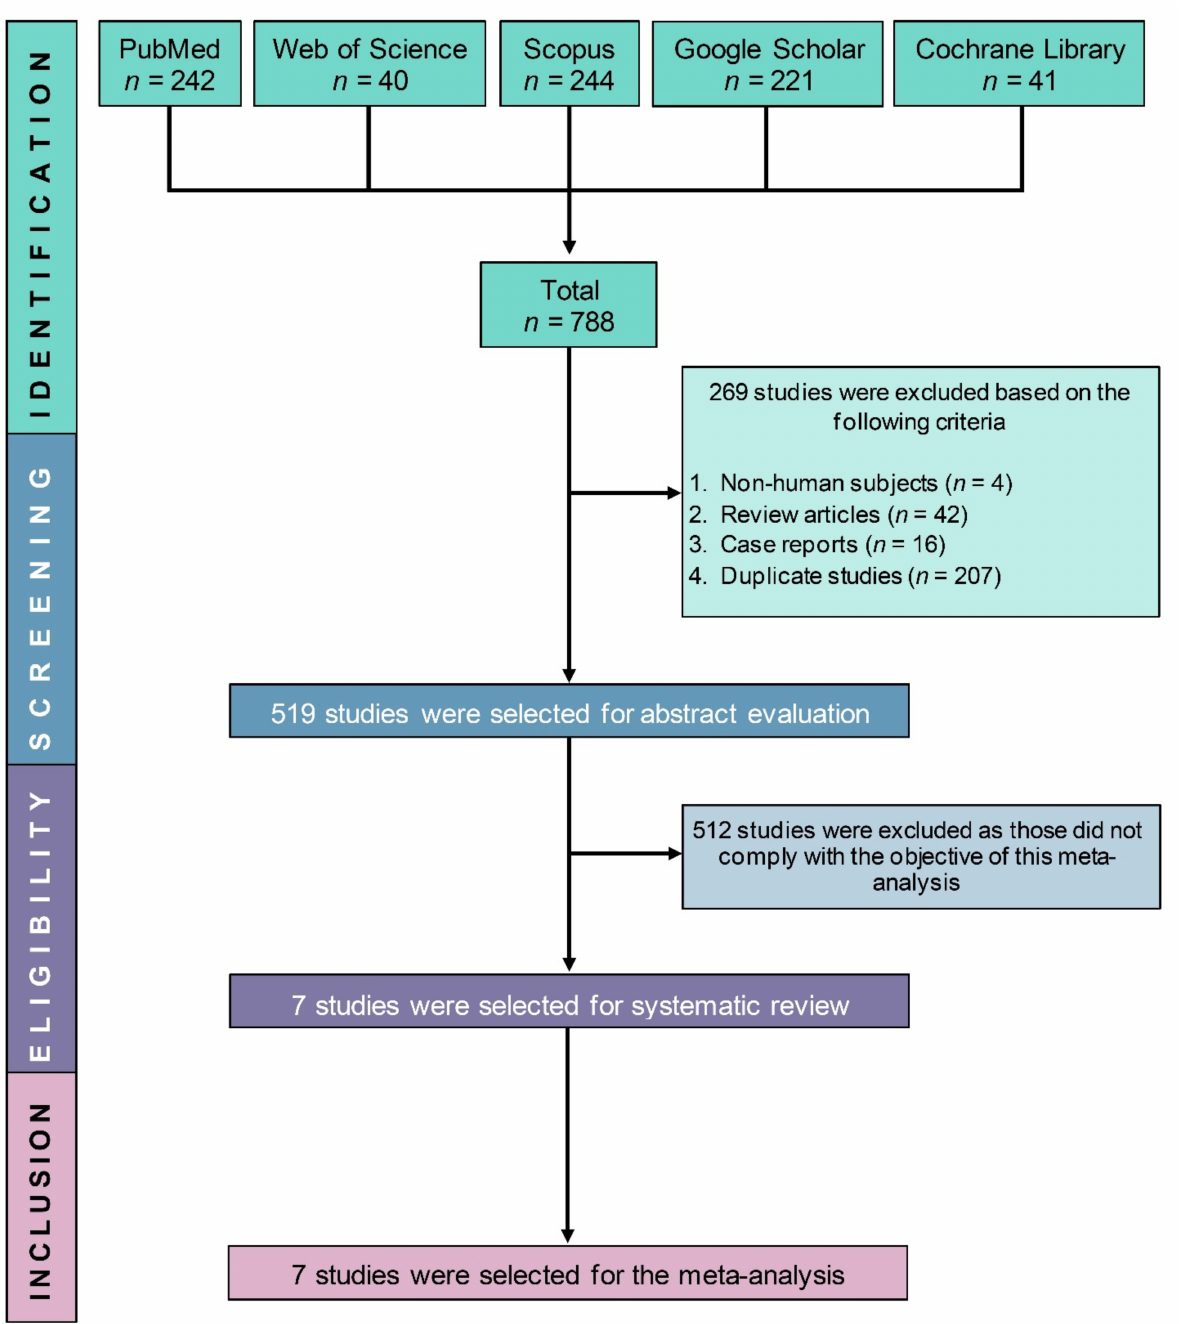
Figure 1. PRISMA flow diagram of study